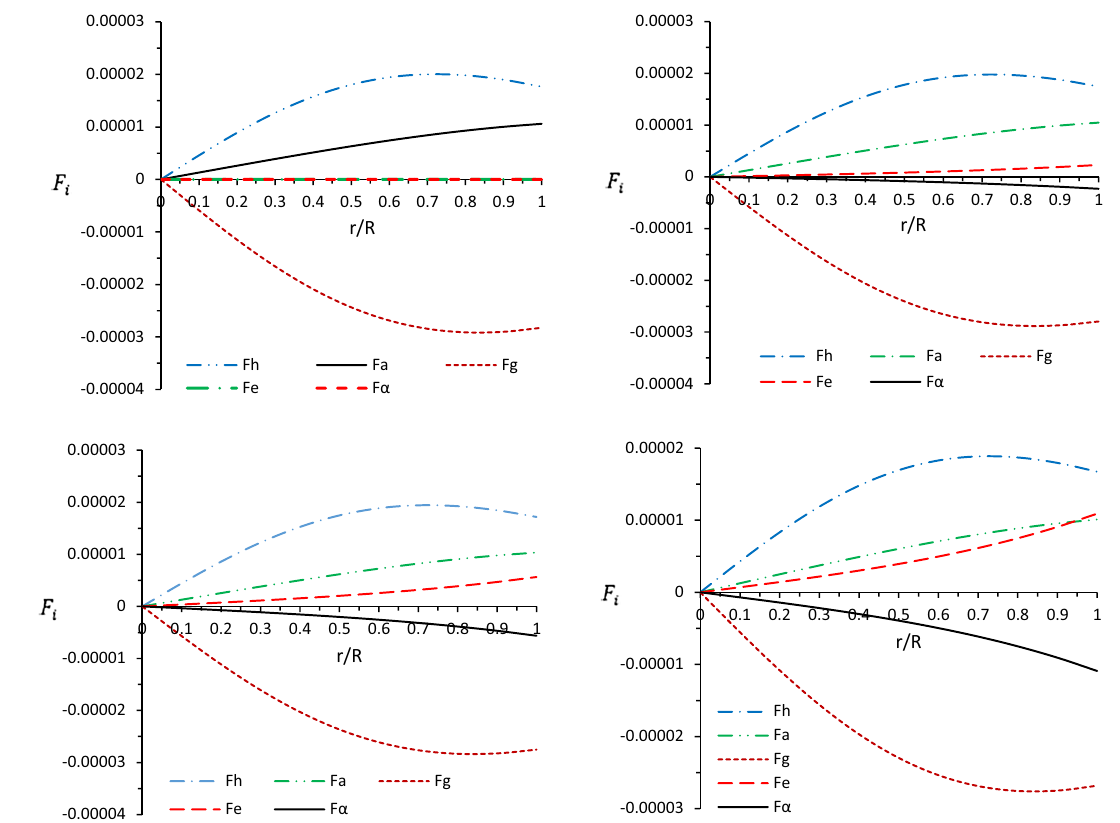
Fig. 4 The behavior of different forces verses radial coordinate r / R . The description of the figures as follows: (i) top left for α = 0 . 0, (ii) top right for α = 0 . 10, (iii) bottom left for α = 0 . 25, and (iv) bottom right for α = 0 . 50. For plotting of this figure we have taken the mass-radius ratio M / R = 0 .